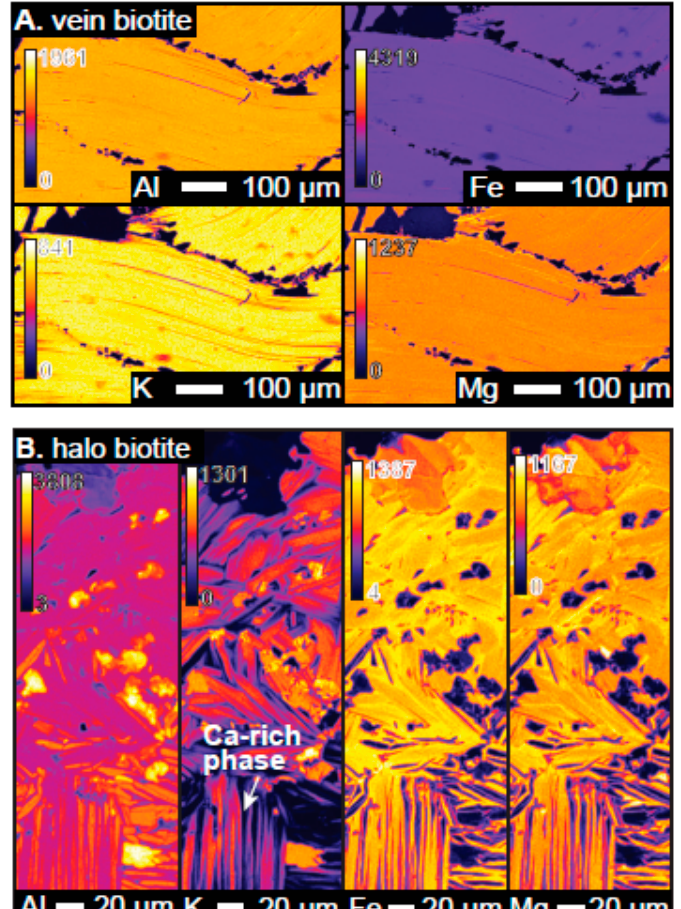
Figure 4. ( A ) Si vs. X Mg binary diagram showing the Mg-rich biotitic compositions of all four biotite populations with relatively elevated di-octahedral mica proportions. Note, barren biotite